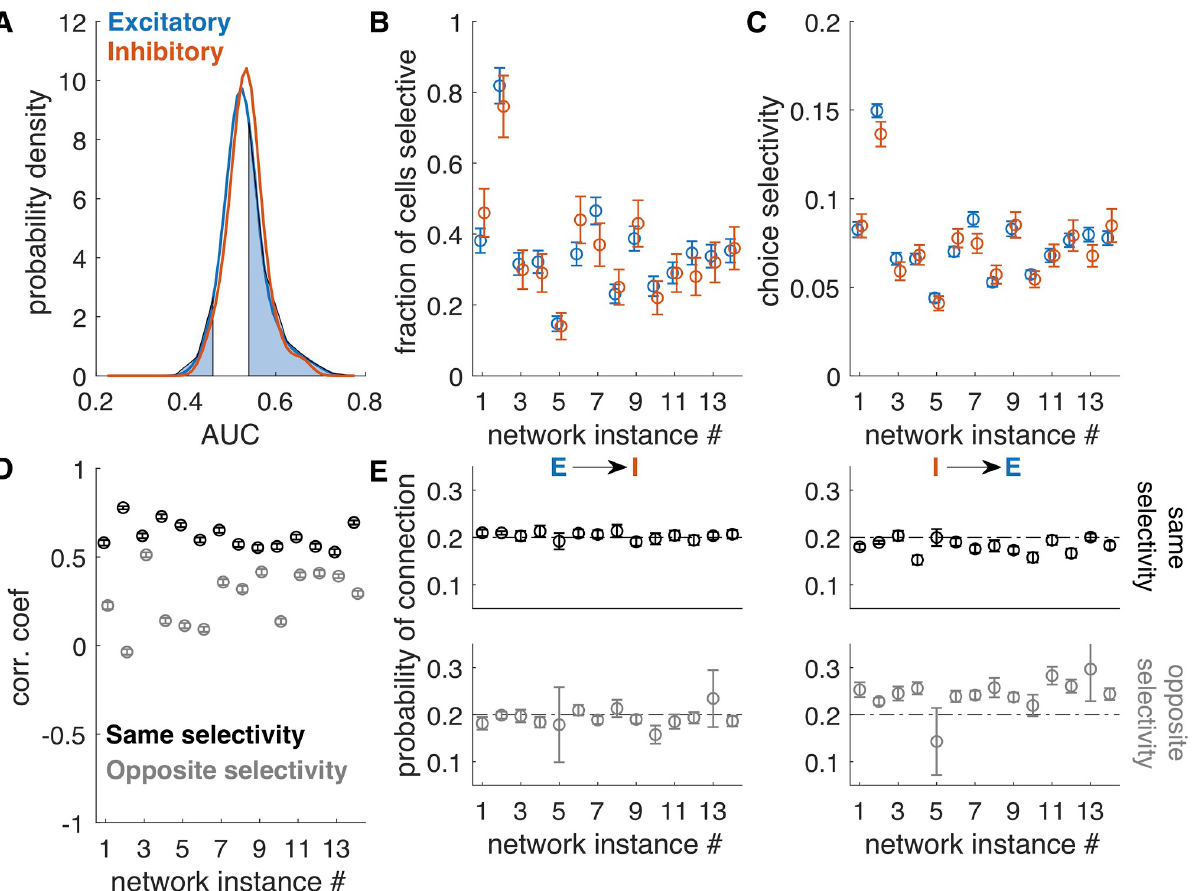
Fig 2. Weak selectivity in both excitatory and inhibitory cells. A. Distribution of AUC values for a single simulation, for excitatory (blue) and inhibitory (red) cells. Shaded regions are those AUC values exceeding significance bounds generated by shuffling trial labels, shown for excitatory cells only. Bounds for inhibitory cells are similar. B. The fraction of cells selective is the fraction of cells in the excitatory or inhibitory populations whose AUC exceeded the significance bounds. The fraction was variable across network realizations, but within each network, it was similar for excitatory and inhibitory cells. Error bars are derived from counting statistics. C. Average choice selectivity (defined as in [1] as the average of 2| AUC − 0.5|). Averages are over all cells (selective and non-selective) and error bars are SEM. D. Correlations (average value) among cells that share the same selectivity is higher than among cells that have opposite selectivity. Error bars are SEM. Correlations are substantial ( > 0.5) because there is no internal noise in the network (all noise is input-driven, and shared across cells). E. Probability of connection for four combinations of pairs of cell types and selectivity: excitatory to inhibitory, with the same selectivity; excitatory to inhibitory, with opposite selectivity; and inhibitory to excitatory with same and opposite selectivity. Error bars are derived from counting statistics.